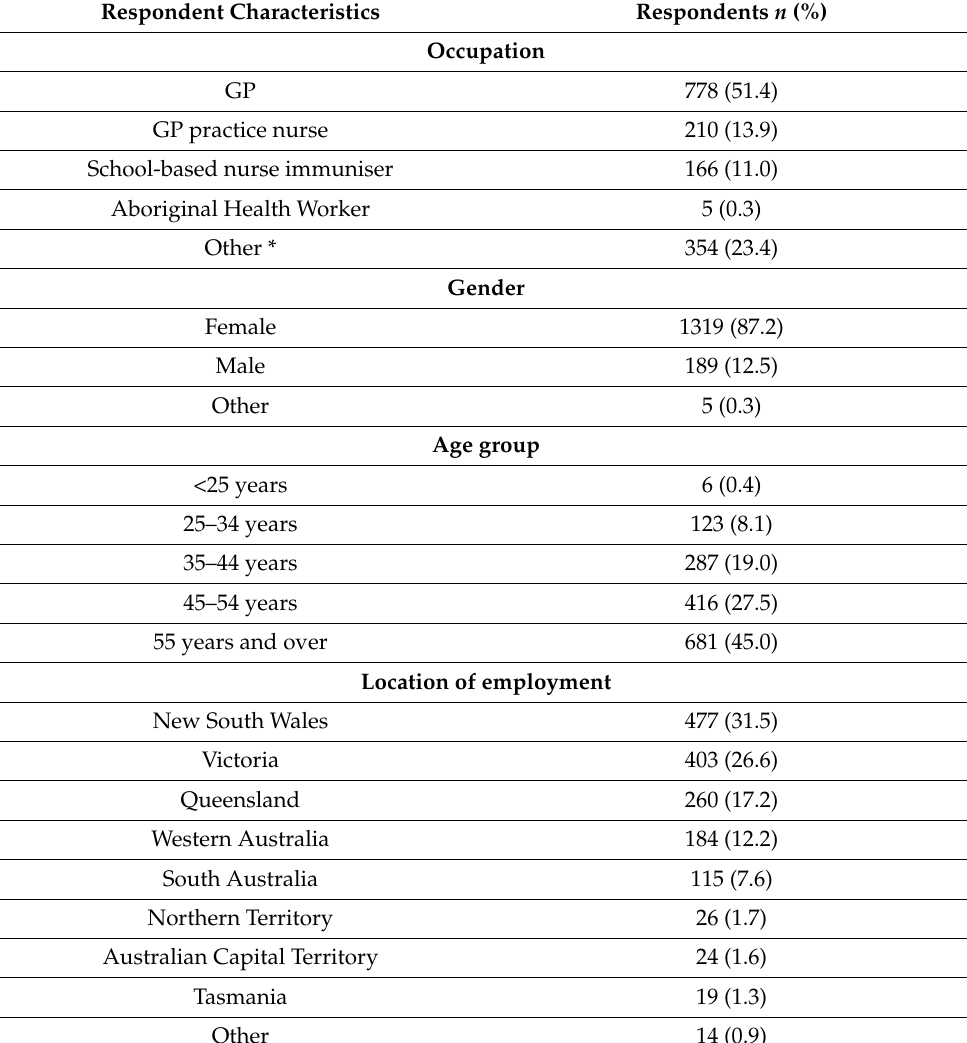
Table 2. Characteristics of survey